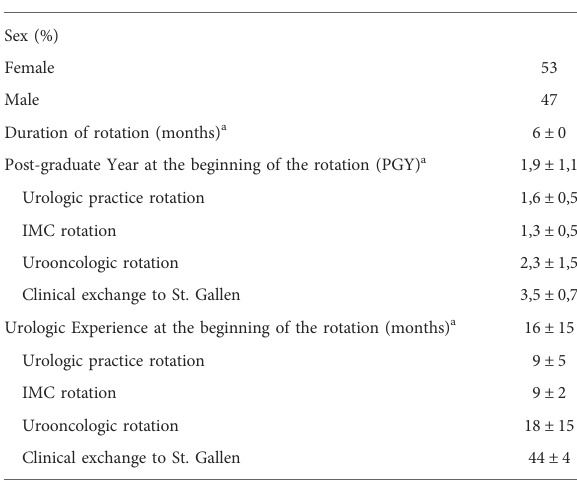
TABLE 1 Baseline characteristics of the participating residents at the residency rotation program at the university hospital